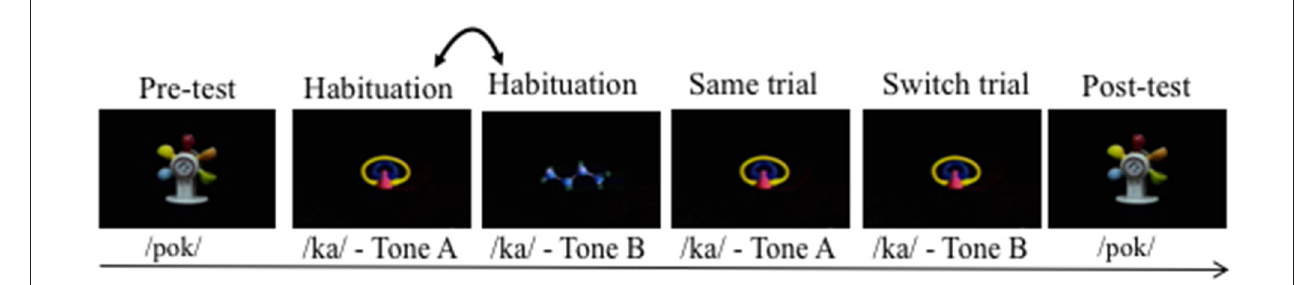
FIGURE 2 | Graphical representation of the Switch task. The doubled-headed arrow indicates that /ka/-Tone A and /ka/-Tone B were presented in alternation in habituation, until the habituation criterion was reached.